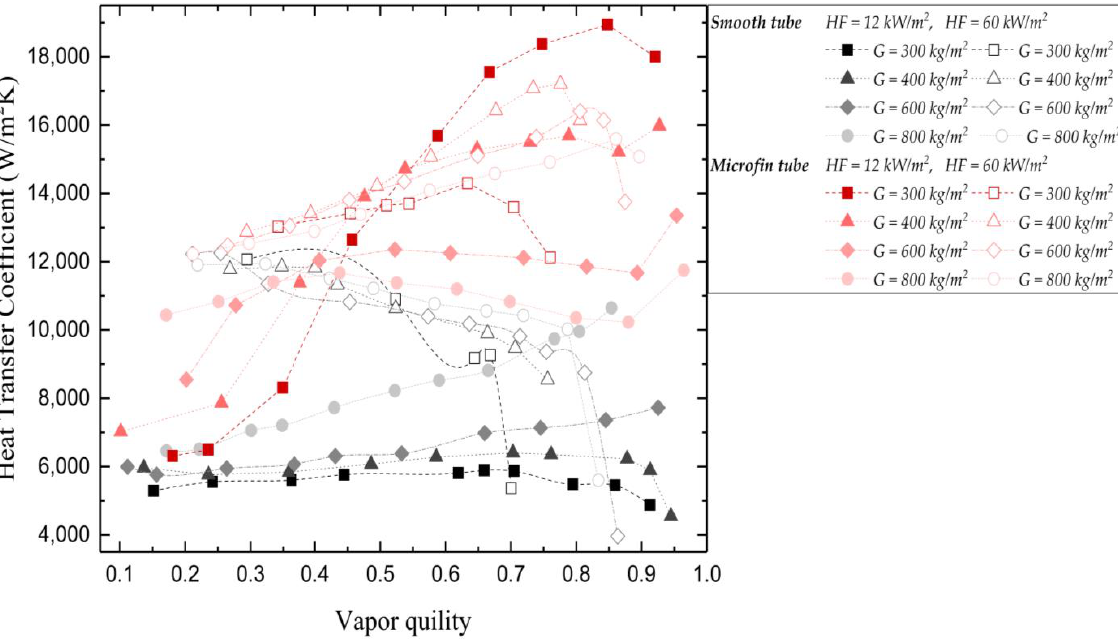
Figure 12. Effect of mass velocity on flow boiling HTCs at two heat fluxes (i.e., 12 and 60 kW/m 2 ) [73]. Figure 13. Mass velocity influence on two-phase frictional pressure drop at a T sat = 20 °C and HF = 30 kW/m 2 [73].